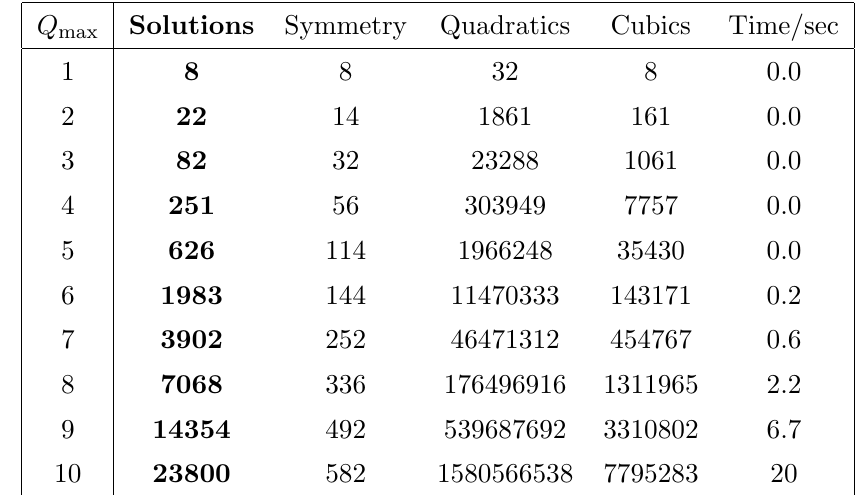
Table 2 . Number of inequivalent solutions to the anomaly equations for SM fermion content and di(cid:11)erent maximum U(1) F charge Q max . Each row contains the all-zero charge solution, as well as the solutions indicated in the rows above. The column marked \Symmetry" shows how many of the solutions are CIS, which we can see soon becomes a minority as Q max gets larger. We also list the number of quadratic and cubic anomaly equations checked by the program, as well as the real time taken for computation on a DELL TM XPS 13-9350 laptop.